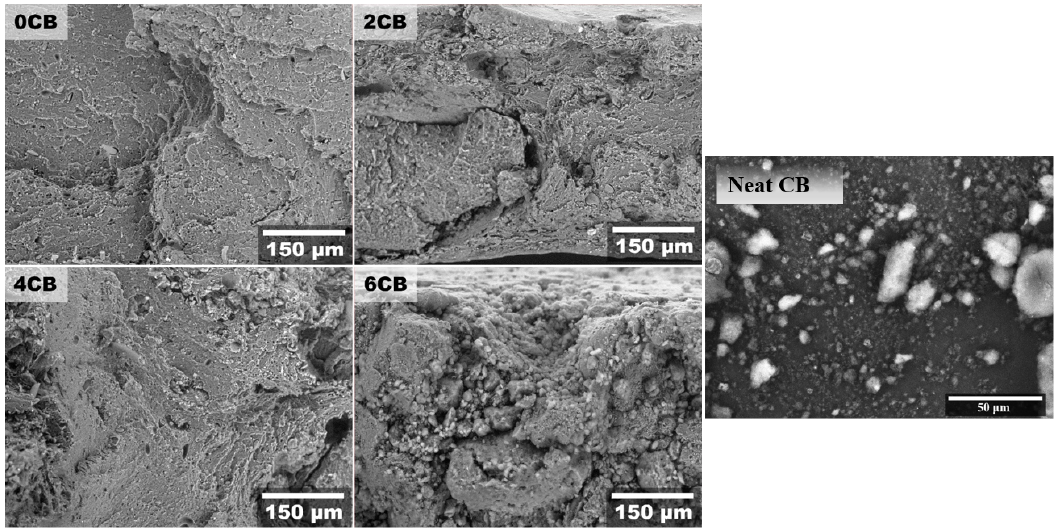
Figure 3. Scanning electron microscope (SEM) micrographs of tensile fractured gluten/CB biocomposites and neat CB.